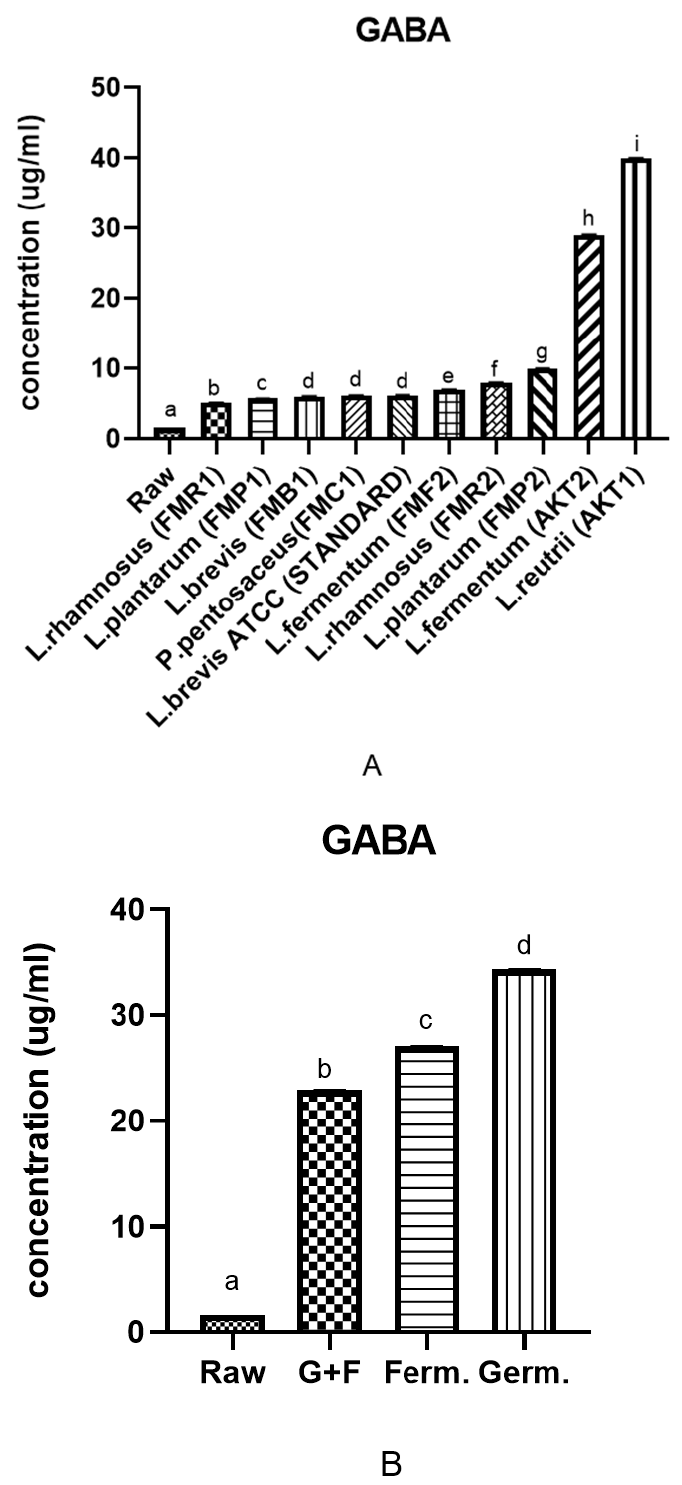
Figure 1. ( A ) Screening of different Lactobacillus strains (48 h fermented). ( B ) Comparison of GABA content among raw, germination (Germ), fermentation (Ferm) and germination combined with fermentation (G+F) treatments. All values are expressed as the mean ± SD of triplicate experiments. The sample concentration used was 1 mg/mL, and a–i superscripts with different letters indicate a significant difference, while sample superscript letters indicate no significant difference ( p < 0.05) found by using SPSS and Graphpad Prism 8.0